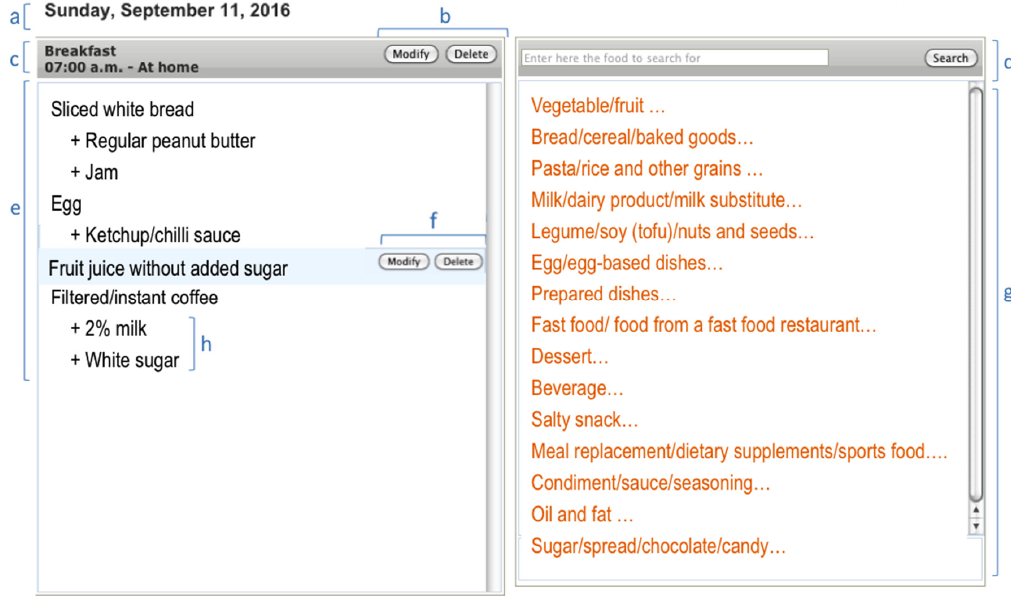
Figure 2. Example of a food selection screen shot from the web ‐ based 24 ‐ h recall (R24W). ( a ) Day